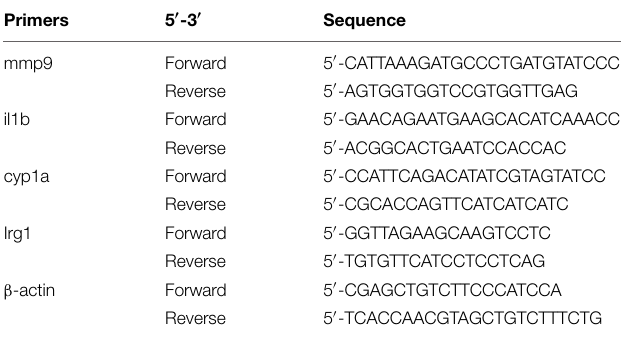
TABLE 1 | Quantitative polymerase chain reaction primer sequences used in this